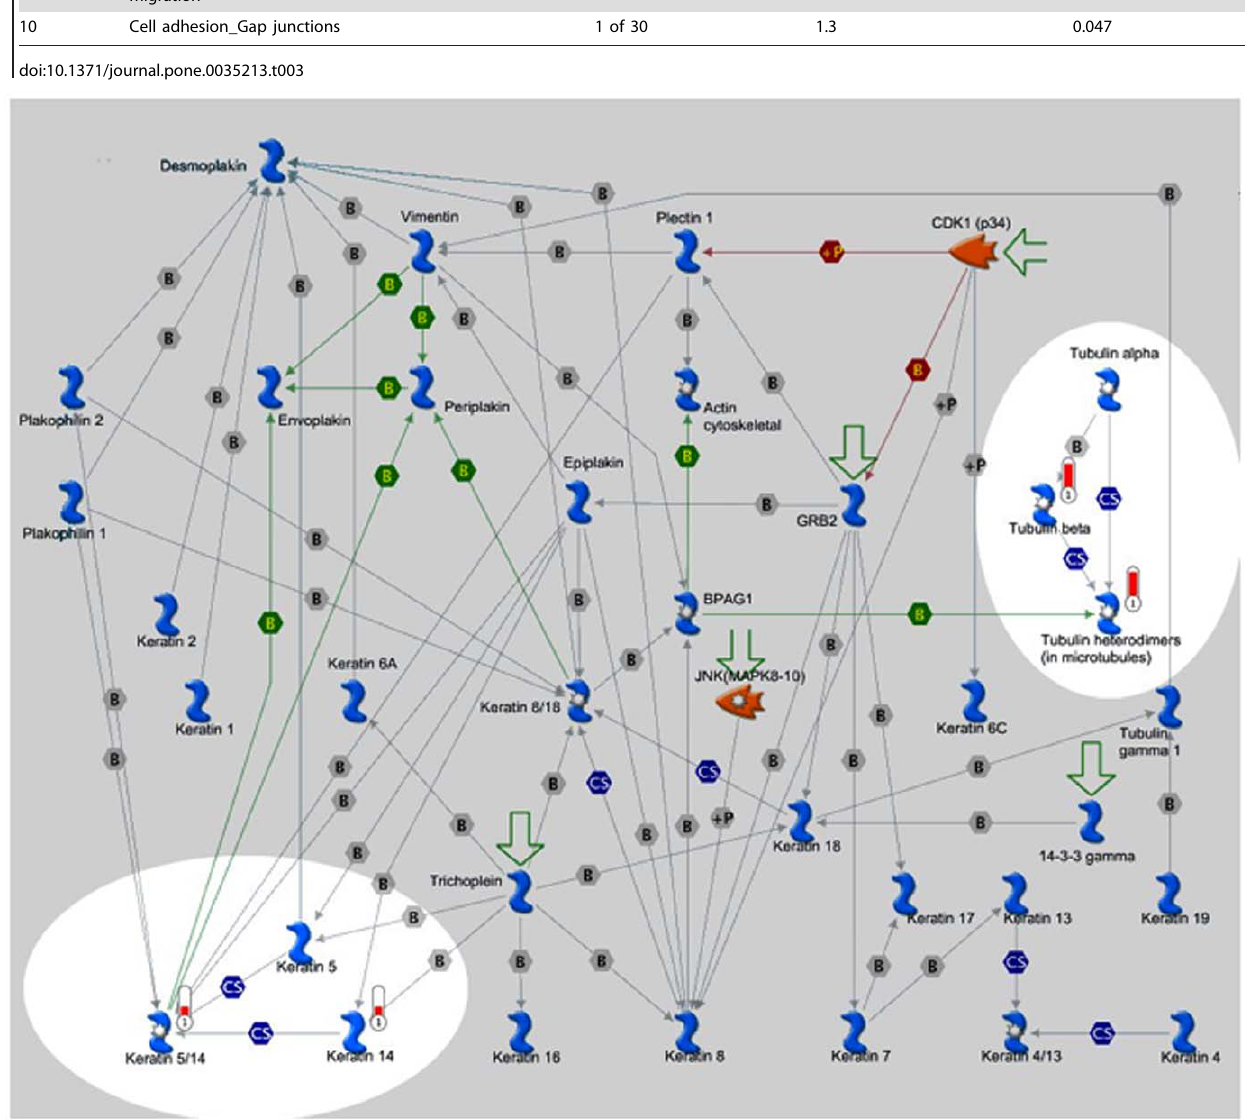
Figure 4. Expression of Genes in the Cytoskeleton remodeling and keratin filament pathways were altered by PTU treatment. Cytoskeleton structure in most eukaryotic cells consists of three distinct interconnected, filament systems: Actin filaments, Microtubules and intermediate filaments. Cell assembly is integrated by the network of intermediate filaments (IFs) and by their interactions with other cytoskeleton structural elements defining cytoarchitecture and cytodynamics. The IF network is critically involved in cell shape control and imparts intracellular mechanical strength. The experimental data are visualized on the map in red (increased expression or up-regulation) histogram. The height of the histogram corresponds to the relative expression value for a particular gene/protein. doi:10.1371/journal.pone.0035213.g004 PLoS ONE |